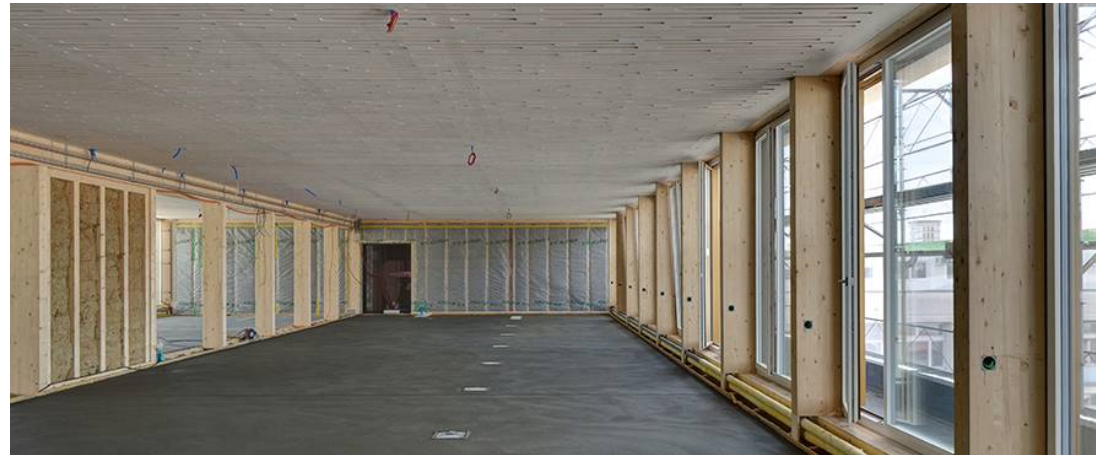
Figure 9. The ceiling slabs with their specially designed acoustic perforations.